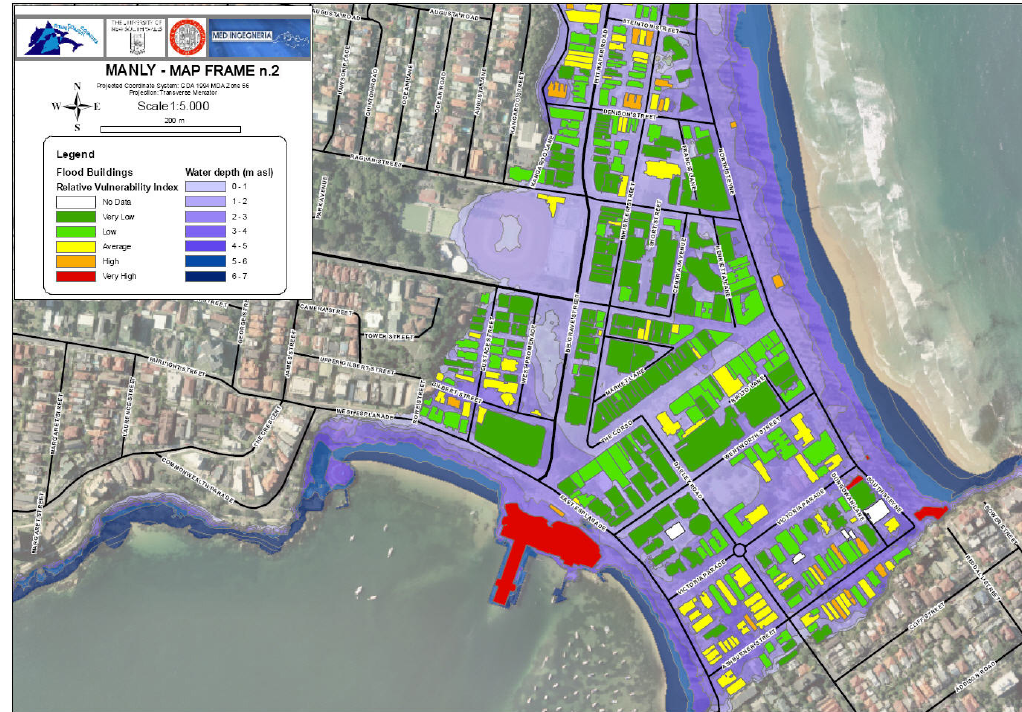
Fig. 4. Tsunami inundation and water depth in the southern part of Manly, the Central Business District (Map Frame n. 2). The RVI scores of every building located within the inundation zone are